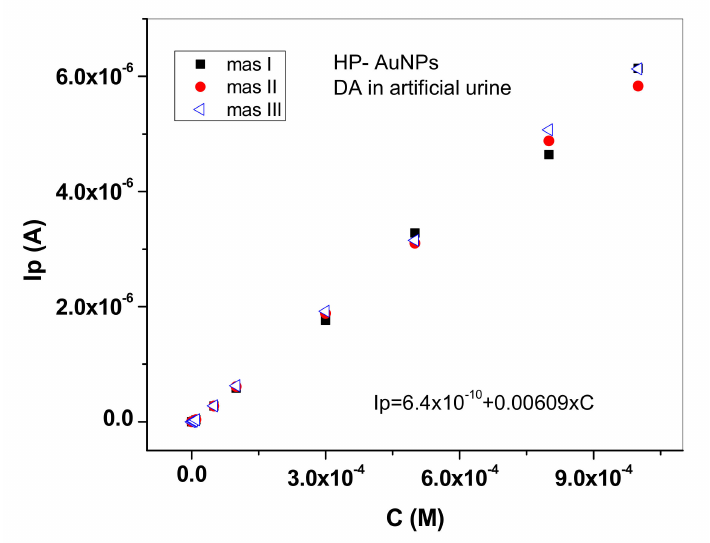
Figure 9. Calibration curves obtained with HP-AuNPs electrode in artificial urine solutions containing di ff erent concentrations of dopamine (10 − 7 − 10 − 3 M); the three consecutive measurements were performed with the same electrode (RSD is 2.92% for 0.5 mM DA